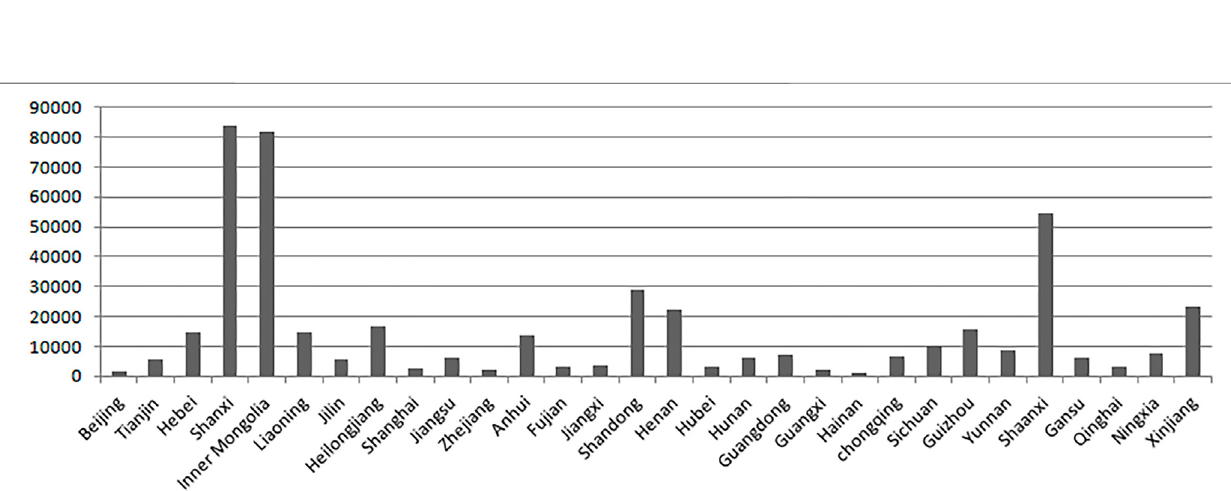
Frontiers in Environmental Science |